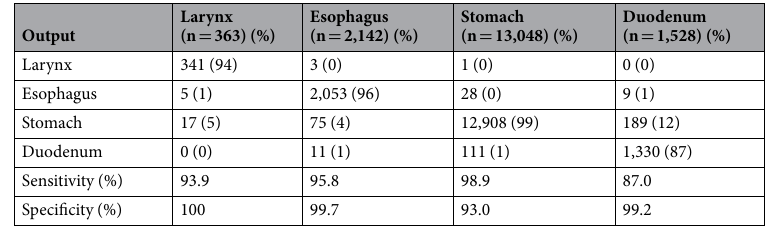
Table 2. Anatomical classification of the images of gastrointestinal scope by CNN.